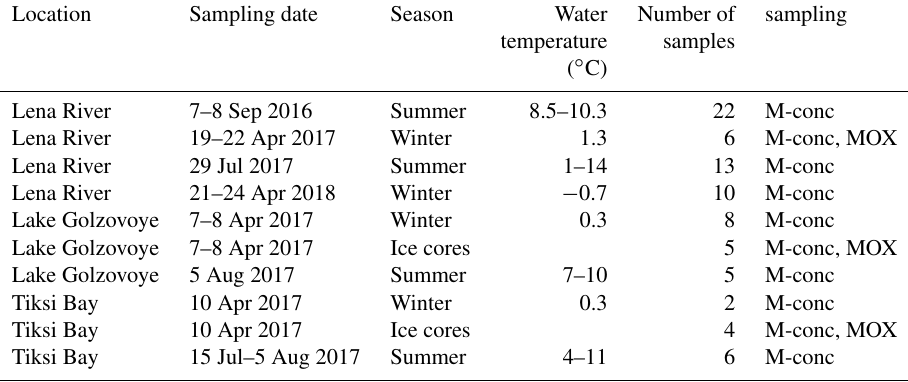
Table 1. Locations and sampling dates of water samples and ice cores for dissolved methane (M-conc) and methane oxidation rates (MOX).